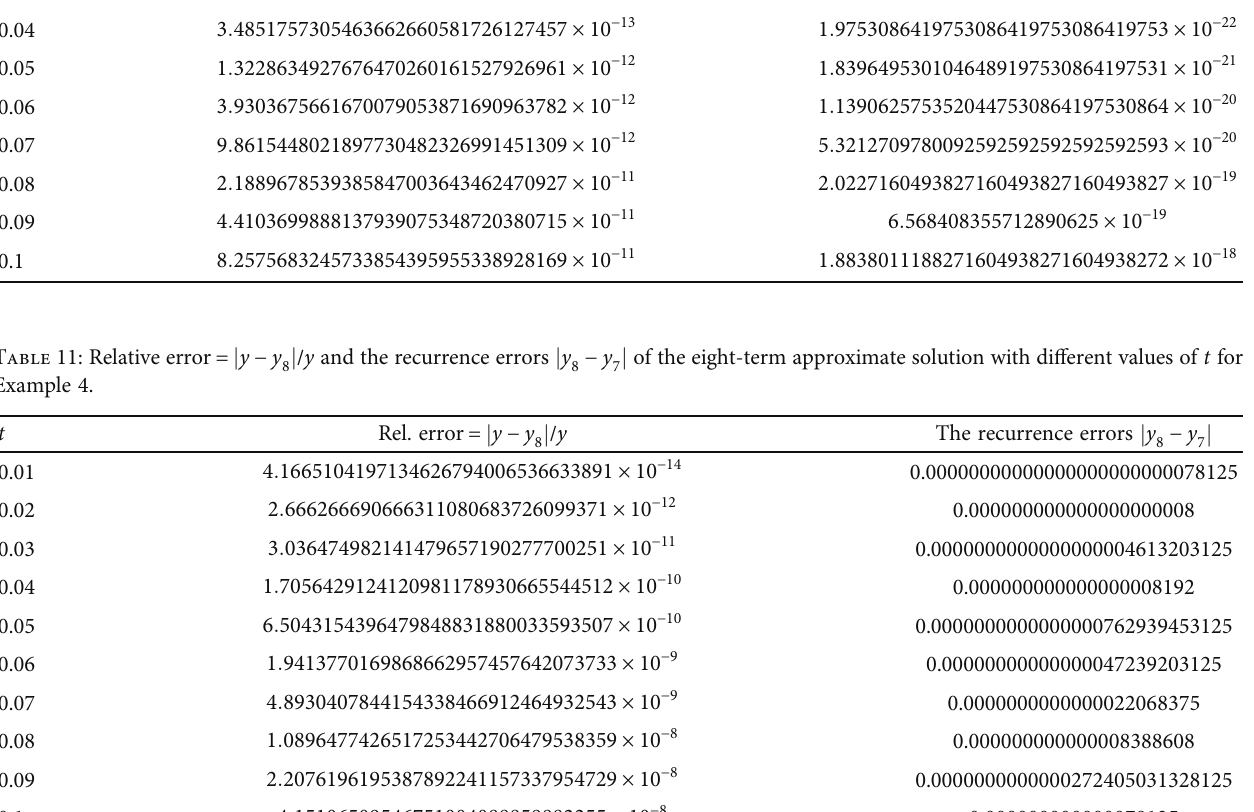
− y 8 7 j of the eight-term approximate solution with di